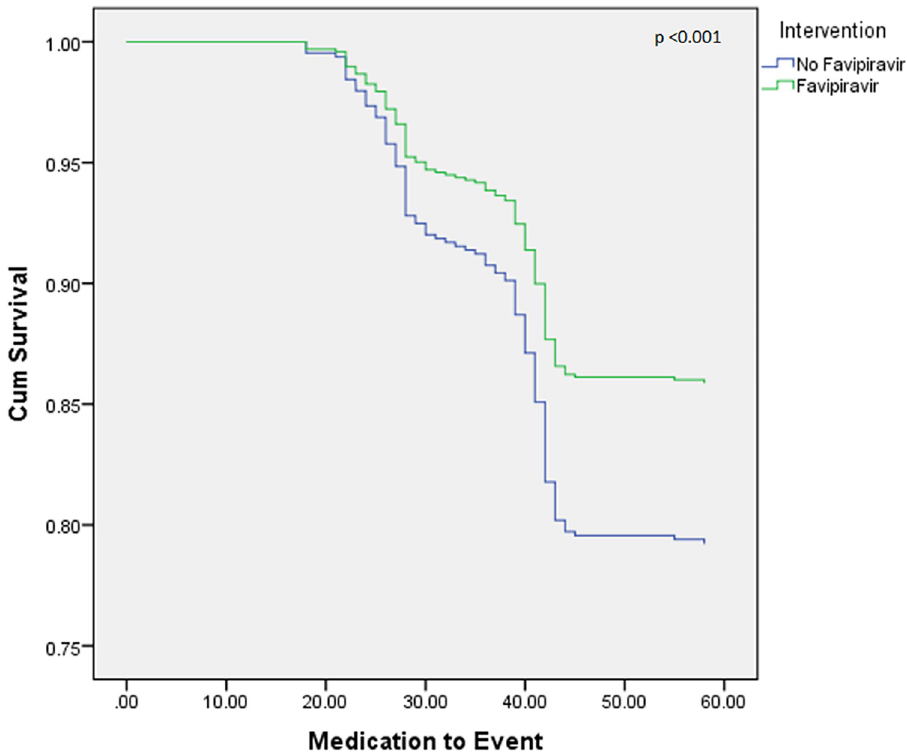
Fig 3. Kaplan–Meier curve of intervention and depression